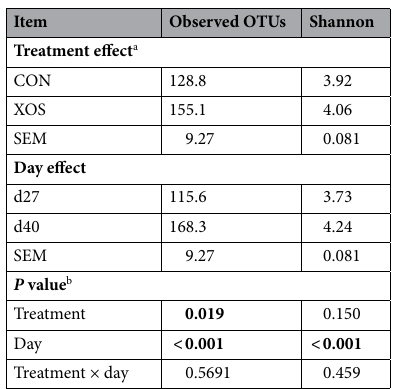
Table 2. Effect of XOS supplementation on observed OTUs and Shannon indexes from the analysis of the fecal microbiota. Significant values are in bold. a CON Piglets supplemented with water, XOS Piglets supplemented with XOS. b P value obtained from ANOVA test.